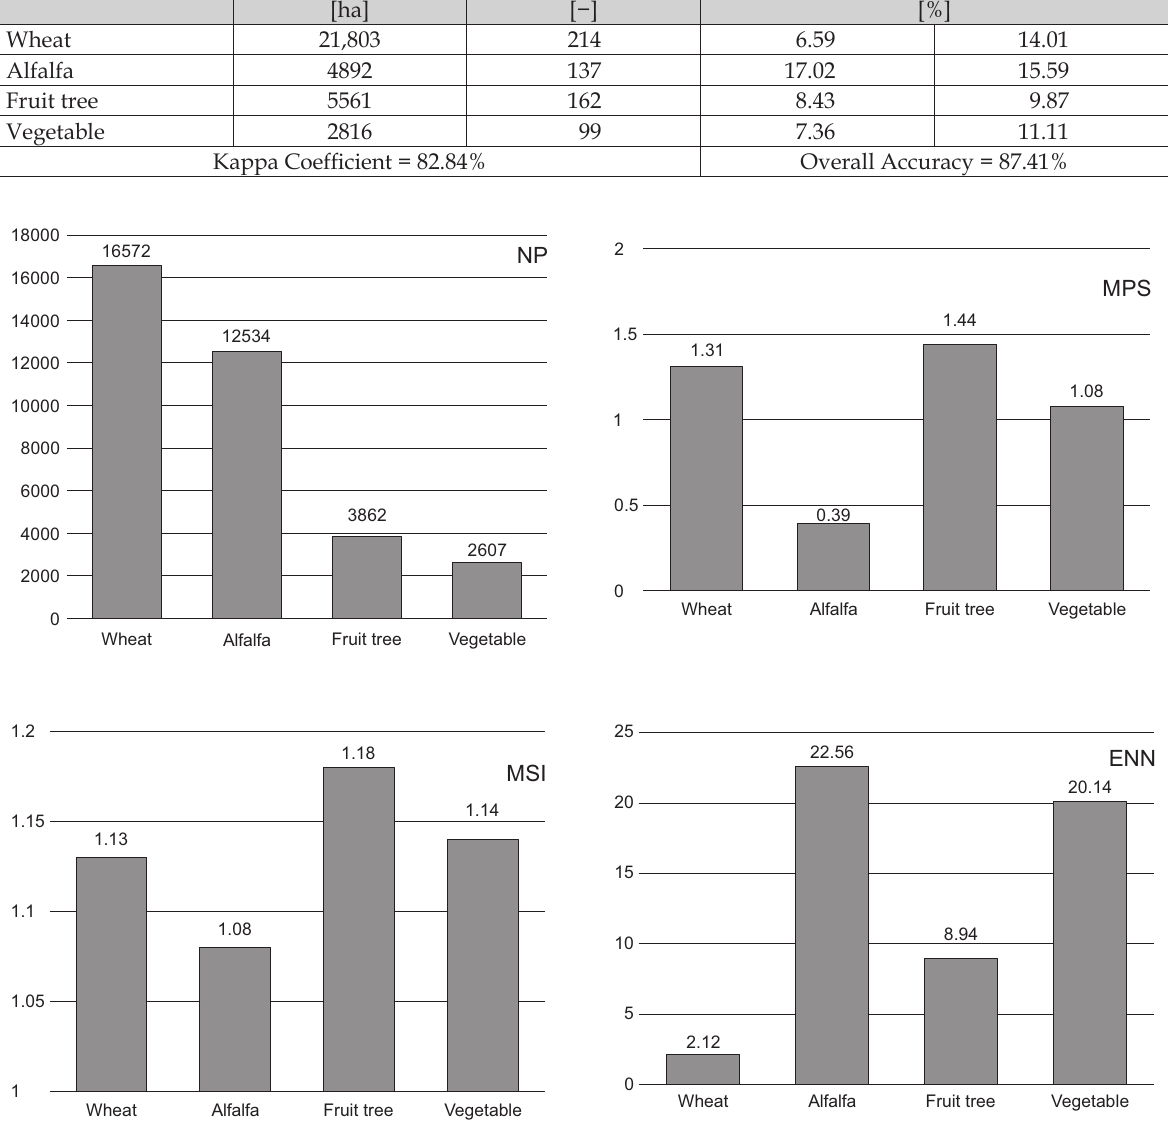
Fig. 3. The results of landscape metrics analysis for each crop type.